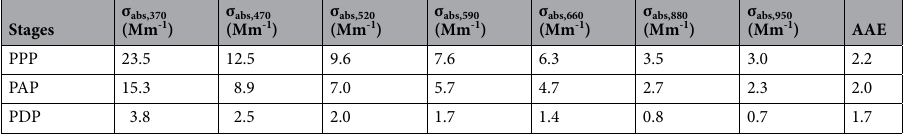
Table 1. Aerosol light absorption